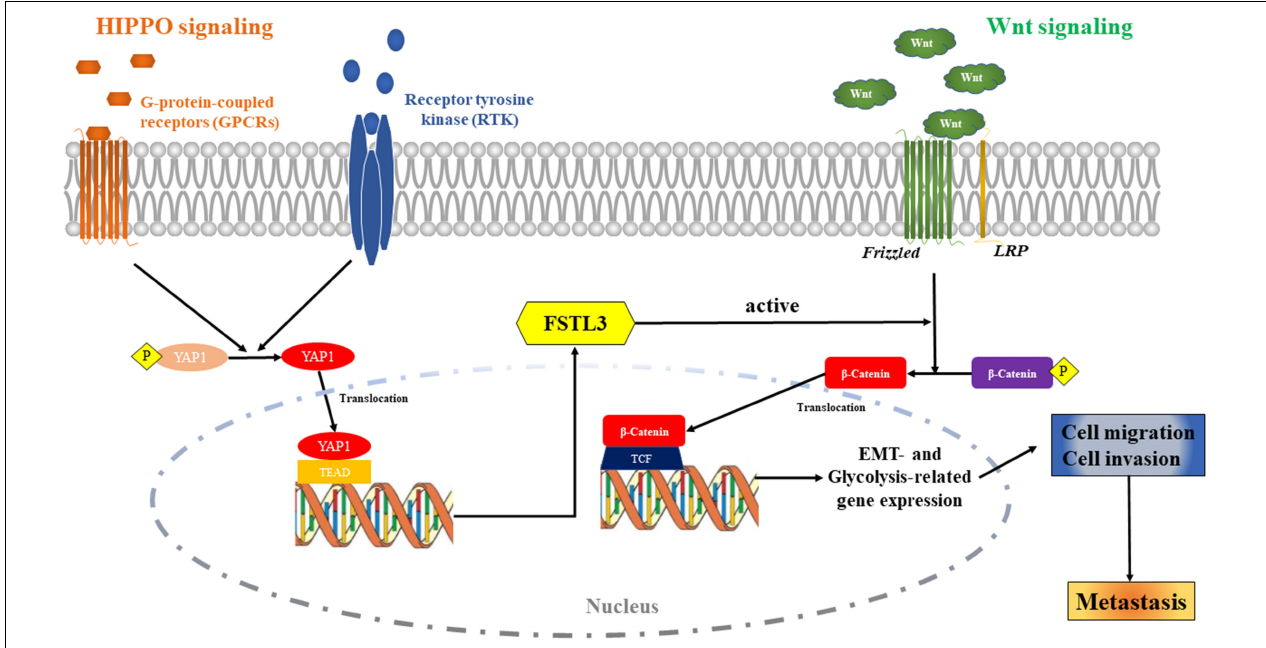
FIGURE 7 | The Cartoon : The activation of HIPPO/YAP1 can induce FSTL3 expression, which then promotes EMT and enhanced aerobic glycolysis to affect invasion, migration and metastasis formation of CRC cells by activating the Wnt/ β -Catenin pathway. FSTL3 serves as a bridging molecule in the crosstalk between HIPPO/YAP1 and Wnt/ β -Catenin pathways and is a crucial regulatory factor of the molecular mechanisms governed by Wnt/ β -Catenin in CRC.